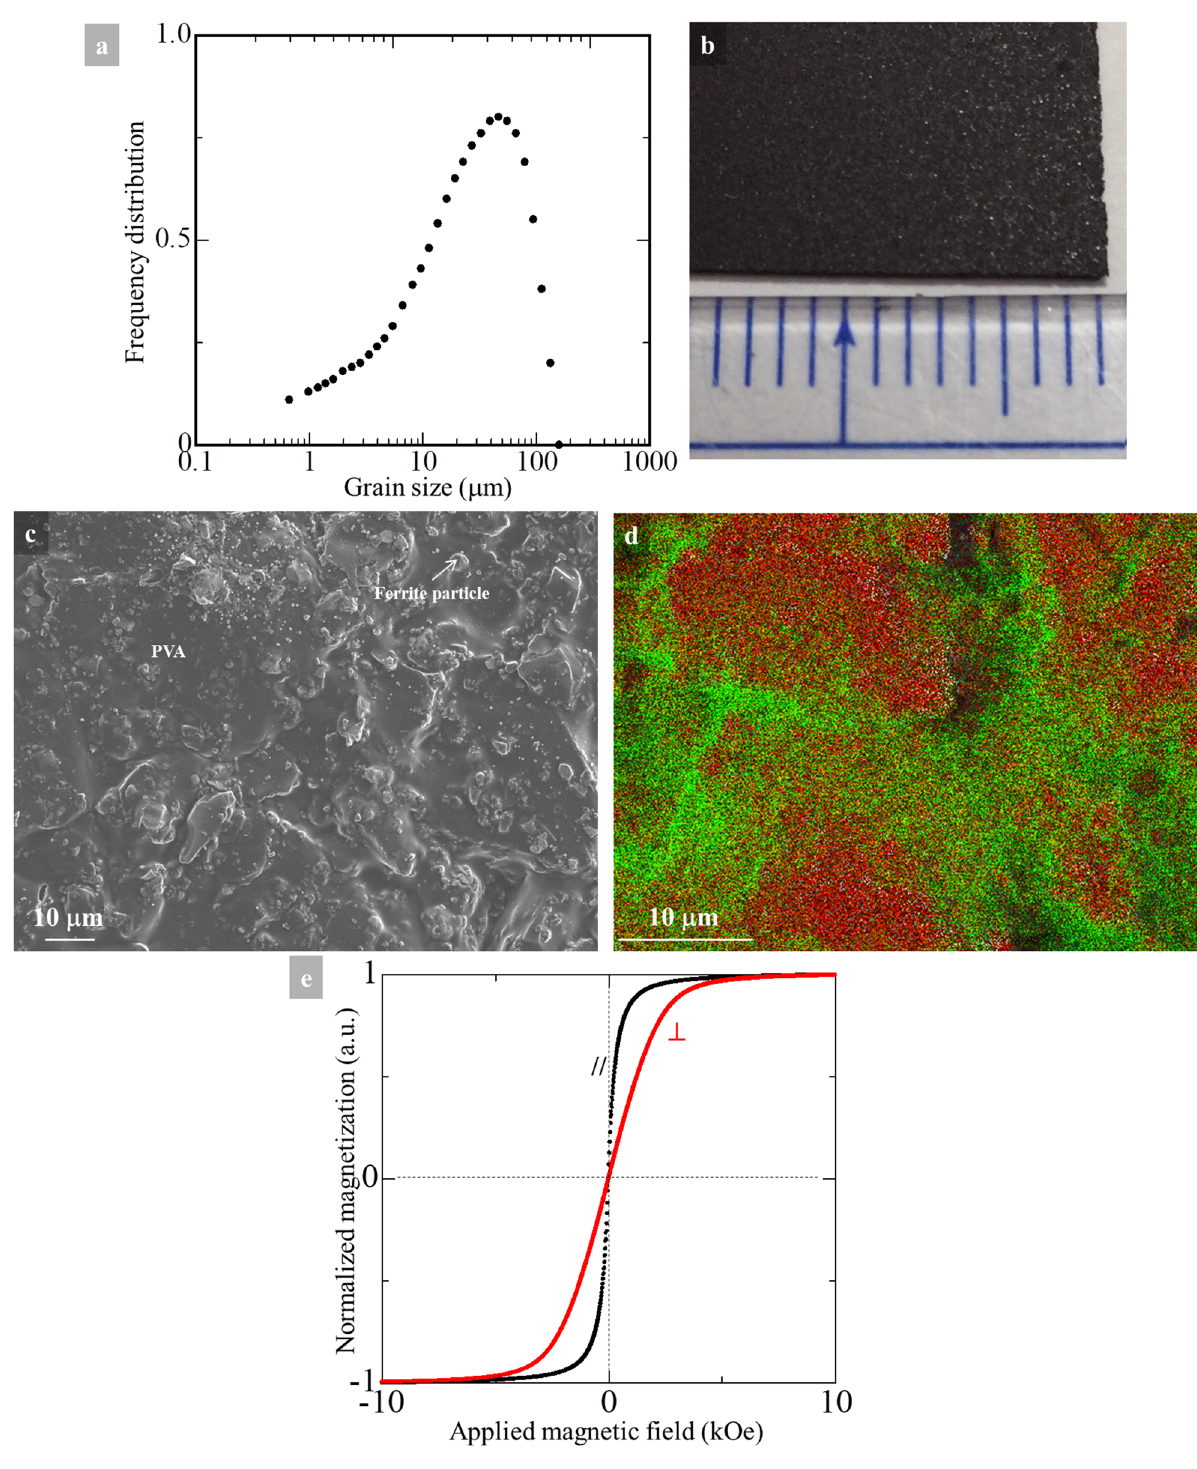
Figure 2. ( a ) Distribution of particle size of ceramic Ni 0.5 Zn 0.5 Fe 2 O 4 powder for the preparation of Ni 0.5 Zn 0.5 Fe 2 O 4 powder/polymer composites sheet. ( b ) The physical appearance of the sheet, and ( c ) the microstructures of the sheet taken by FE-SEM. The distribution of elements in the sheet is shown in ( d ). Fe is represented by red color, while green shows the C distribution. Magnetic hysteresis characteristics of the Ni 0.5 Zn 0.5 Fe 2 O 4 powder/polymer composite sheet at room temperature are shown in ( e ). The external magnetic field is applied normal to the sheet surface (red), whereas the black loop is obtained when the external magnetic field is applied parallel to the surface of the